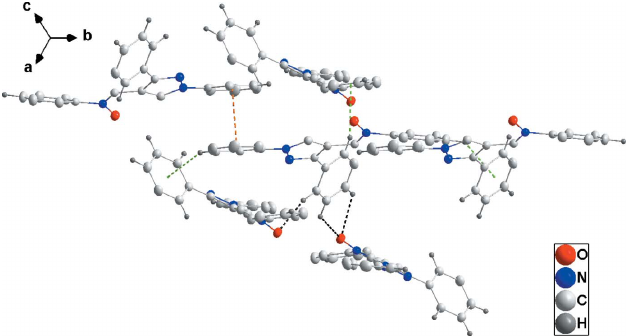
Figure 2 Details of the intermolecular interactions. C—H (cid:3)(cid:3)(cid:3) O hydrogen bonds are shown by black dashed lines while C—H (cid:3)(cid:3)(cid:3) (cid:2) (ring) and offset (cid:2) – (cid:2) stacking interactions are shown, respectively, by green and orange dashed lines.